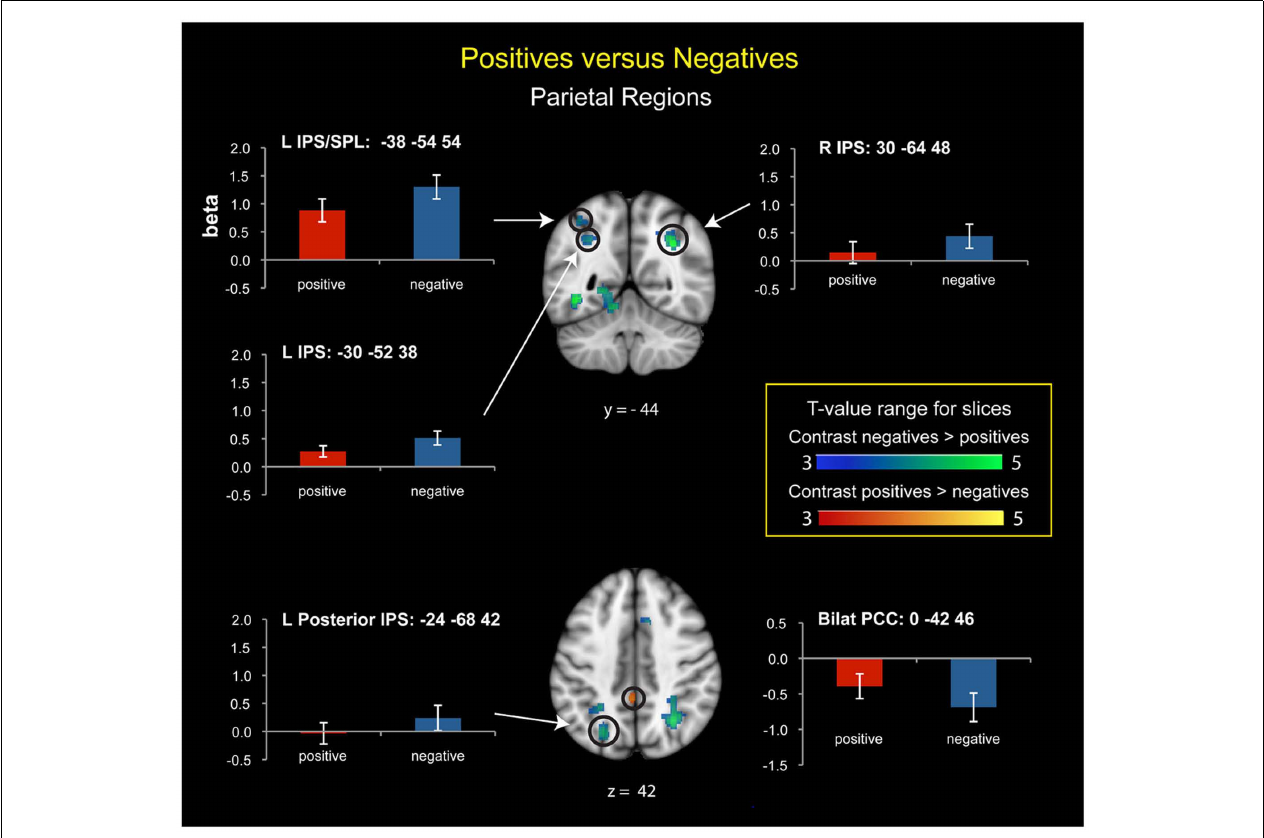
activation for negative than positive numbers, though neither differed from baseline. In the right IPS, there was significant activation for negative numbers; positive numbers did not differ from baseline.The posterior cingulate cortex (PCC) showed greater deactivation to negative compared to positive